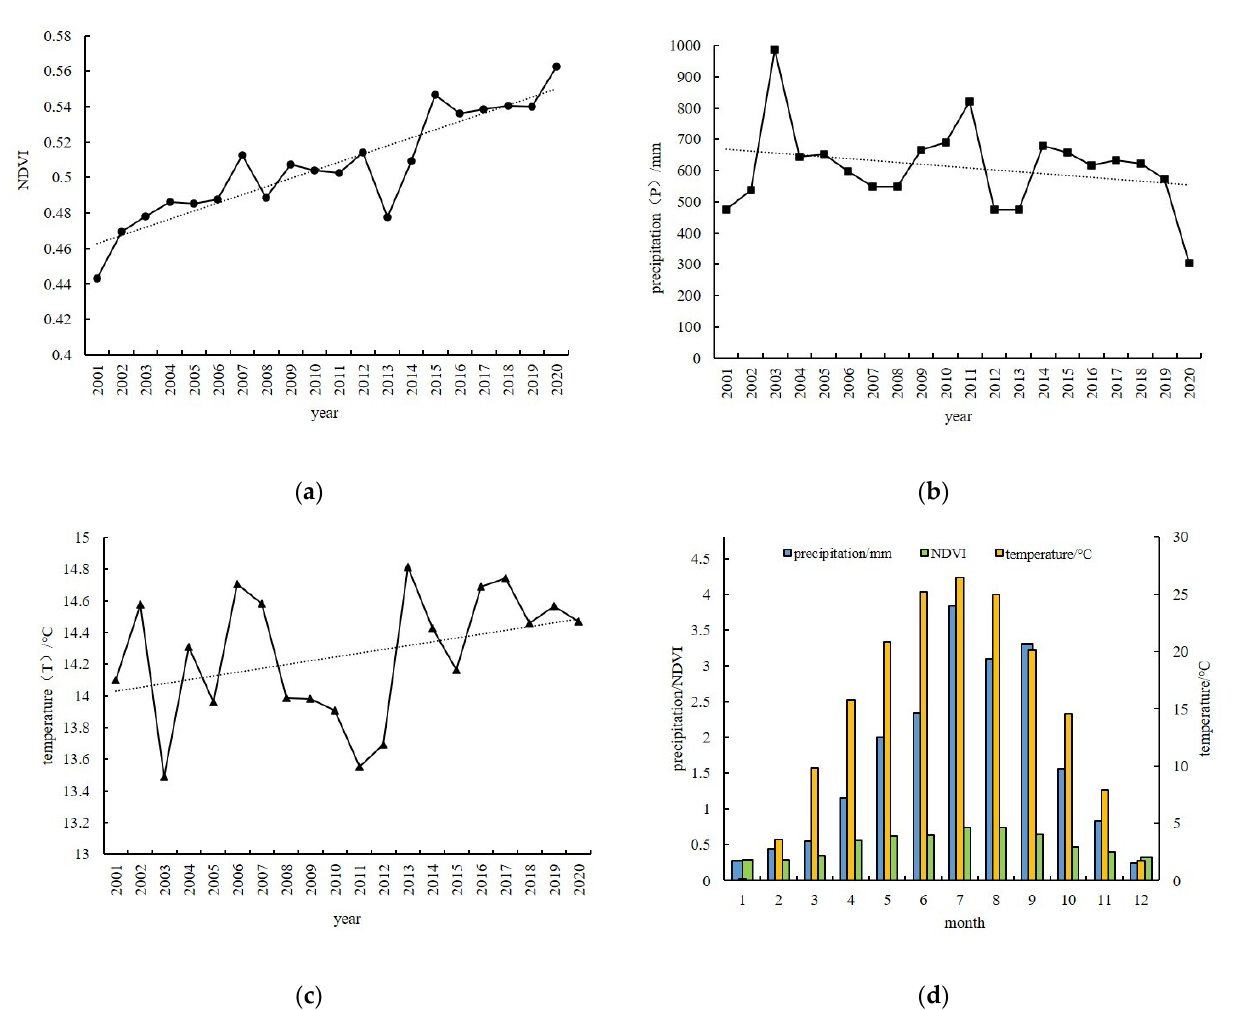
Figure 6. Interannual and intra-annual changes in NDVI, precipitation, and temperature: ( a ) NDVI interannual change; ( b ) precipitation interannual change; ( c ) temperature interannual change; ( d ) NDVI, precipitation, and temperature monthly change.